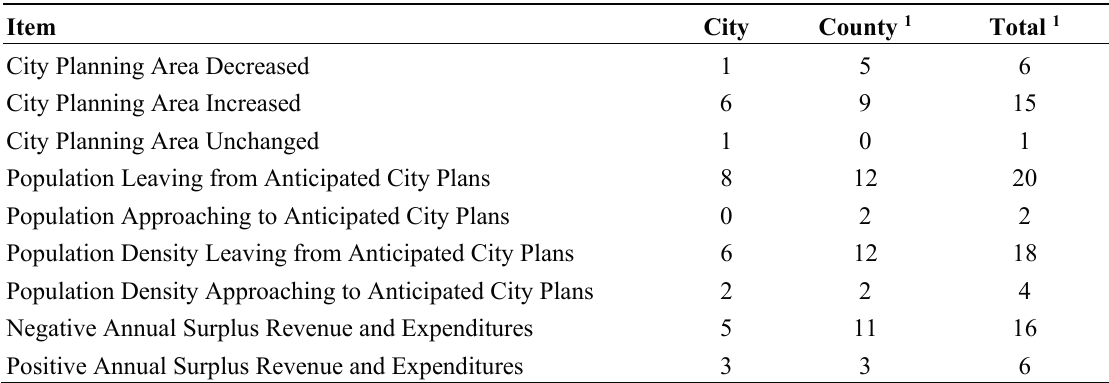
Table 5. The factors related to city sprawl for Taiwan cities approaching or leaving the anticipated city plans on population, population density, and city planning area; comparing the annual surplus revenue and expenditures from 2002 to